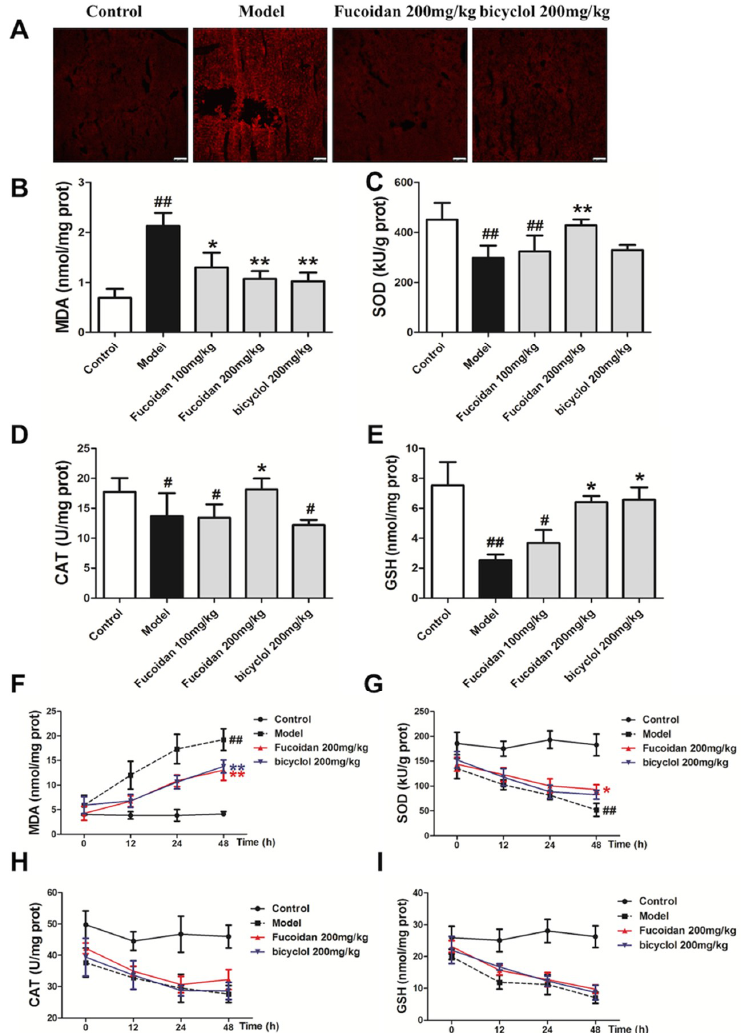
Figure 2. Fucoidan inhibited APAP-induced oxidative stress in mice. Male ICR mice were randomly divided into control, model, fucoidan 100 mg/kg, fucoidan 200 mg/kg, and bicyclol 200 mg/kg groups. After pretreating with fucoidan or bicyclol for 7 days, the acute hepatic injury model was induced by intraperitoneal injection of 500 mg/kg APAP, and the normal group was injected with an equal amount of saline. The mice continued to be administered fucoidan or bicyclol once a day, and were sacrificed at an indicated time. Hepatic tissues were taken for frozen sections and other detections. ( A ) Hepatic sections (4 h) were stained with dihydroethidium (DHE) fluorescent dye, and the levels of superoxide anion were observed with a confocal microscope (bar = 100 µm). ( B , F ) Malondialdehyde (MDA) and ( E , I ) glutathione (GSH) levels, ( C , G ) superoxide dismutase (SOD) and ( D , H ) catalase (CAT) activities in the liver were measured for evaluating the level of hepatic oxidative stress. Data are expressed as mean ± SD, n = 8, # p < 0.05, ## p < 0.01 versus control group; * p < 0.05, ** p < 0.01 versus model